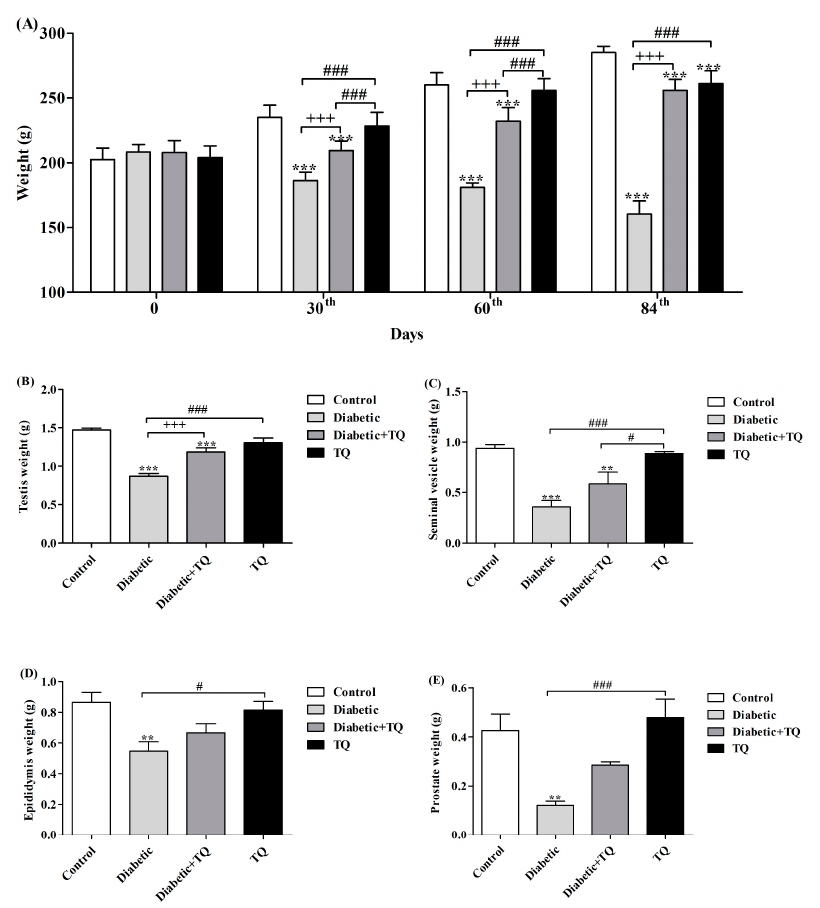
Figure 3. Body weight ( A ), relative weight of testicles ( B ), seminal vesicle ( C ), epididymis ( D ), prostate gland ( E ) in Control, Diabetic, Diabetic + TQ, and TQ groups. ** p < 0.01 and *** p < 0.001 vs. Control. +++ p < 0.001 vs. Diabetic. # p < 0.05 and ### p < 0.001 vs. TQ. TQ; thymoquinone.